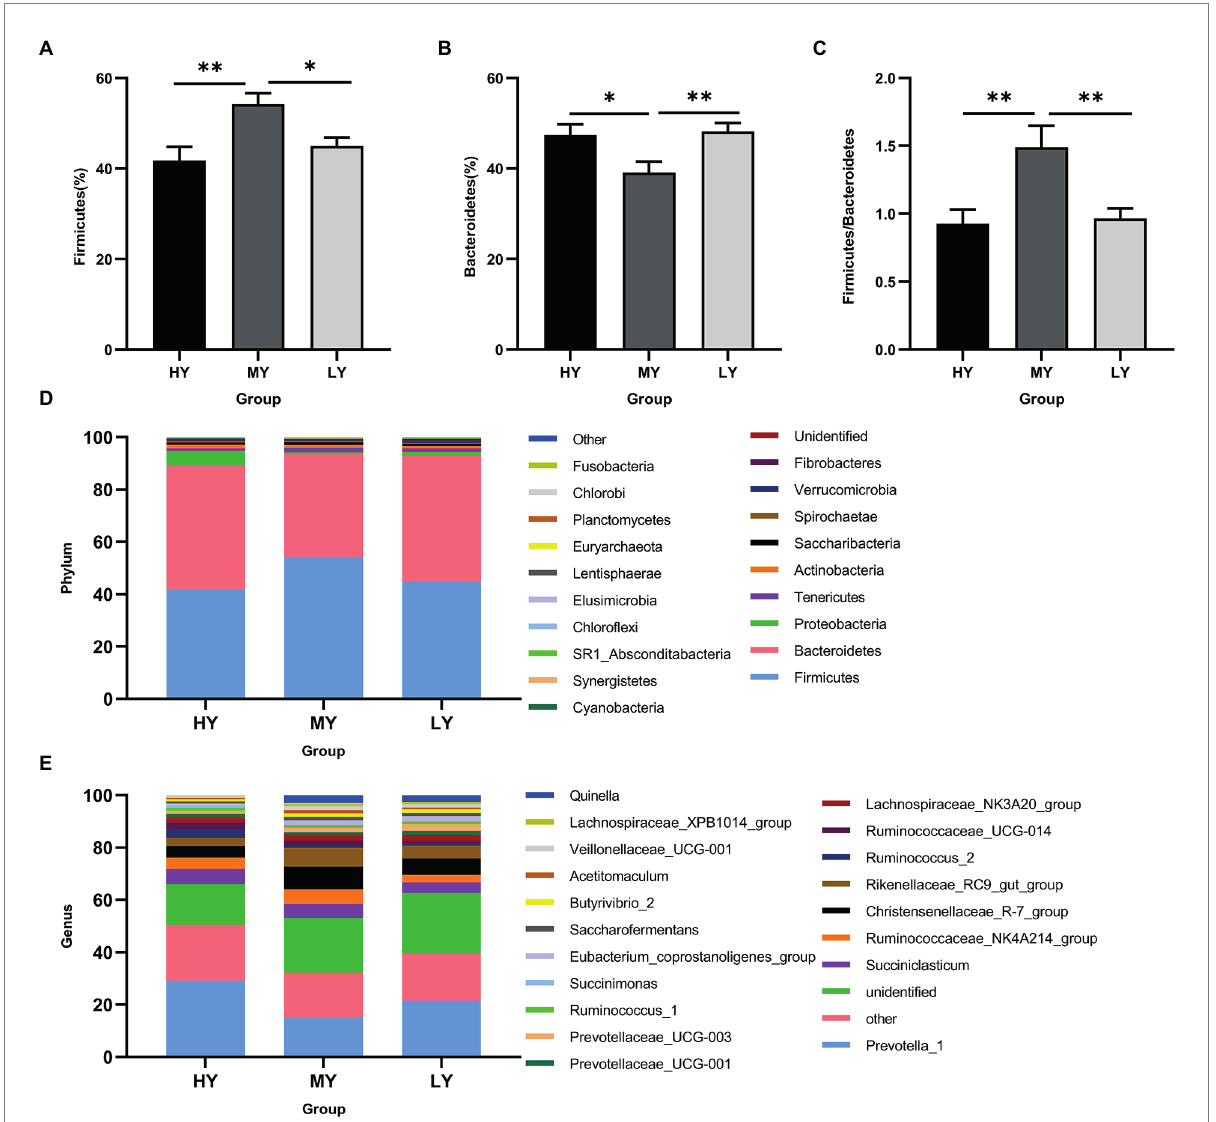
FIGURE 3 Changes in the relative abundance of the dominant phylum and genera in the rumen bacteria among of yak groups. These are (A) Firmicutes, (B) Bacteroidetes, and (C) the ratio of Firmicutes to Bacteroidetes. Relative abundances of bacteria at phylum level (D) and genus level (E)